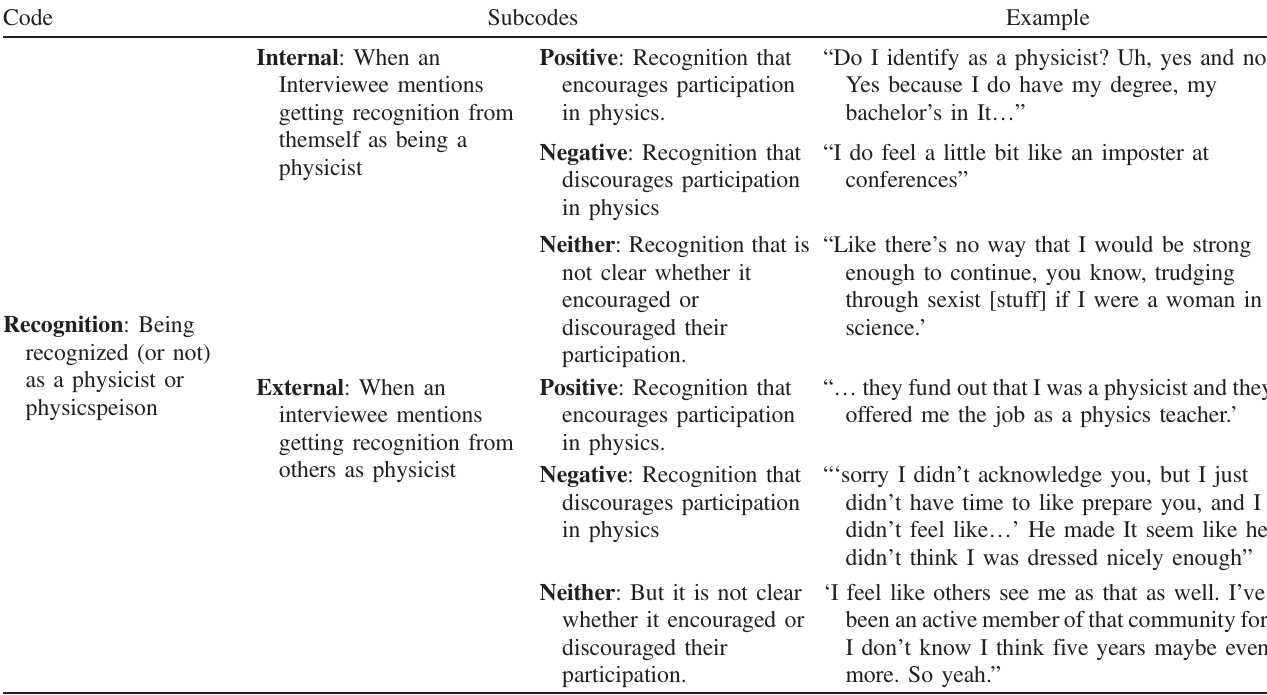
TABLE IV. Details of our recognition construct code definitions. This includes the definition of the main construct, as well as the definitions of each subcode and example from the interviews of Cara, Jeff, Cindy, or Owen.